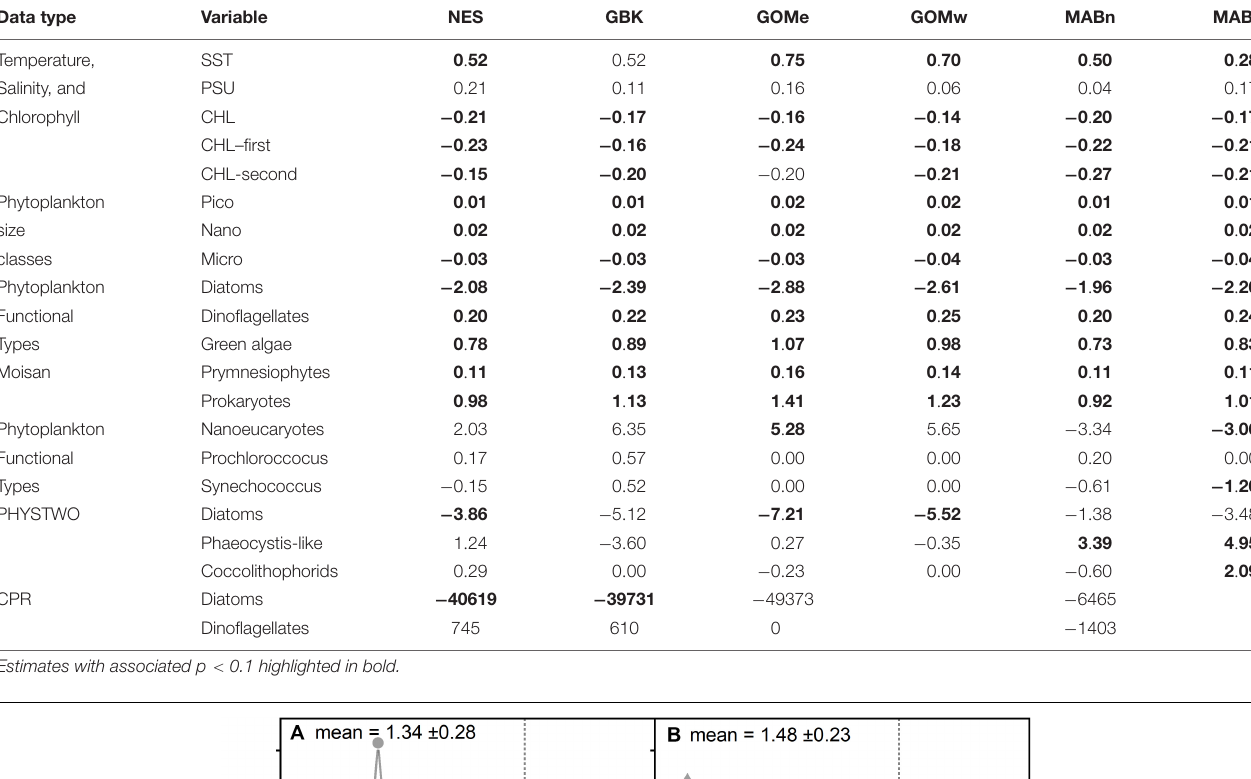
TABLE 1 | Theil–Sen slope estimates expressed in decadal rate of change for environmental variables by NES and NES subareas (NES, GBK, GOMe, GOMw, MABn, and MABs).